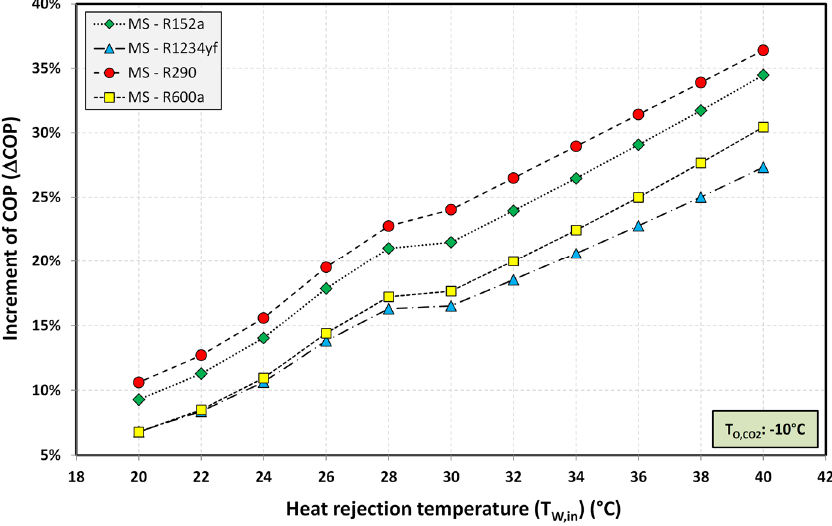
Figure 13. Increment of COP at the optimal operating conditions vs. heat rejection pressure.